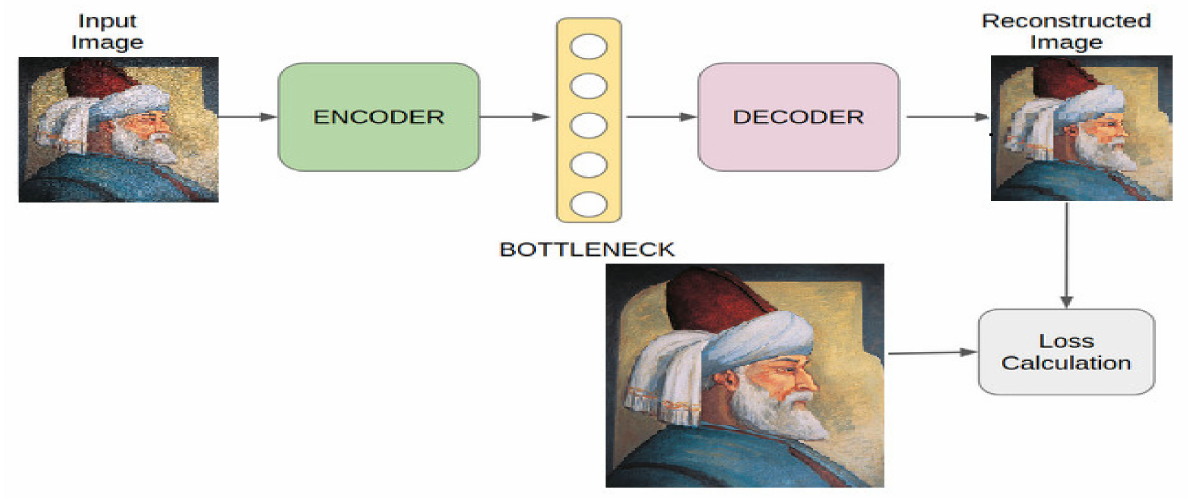
Figure 10. Visual representation of autoencoder